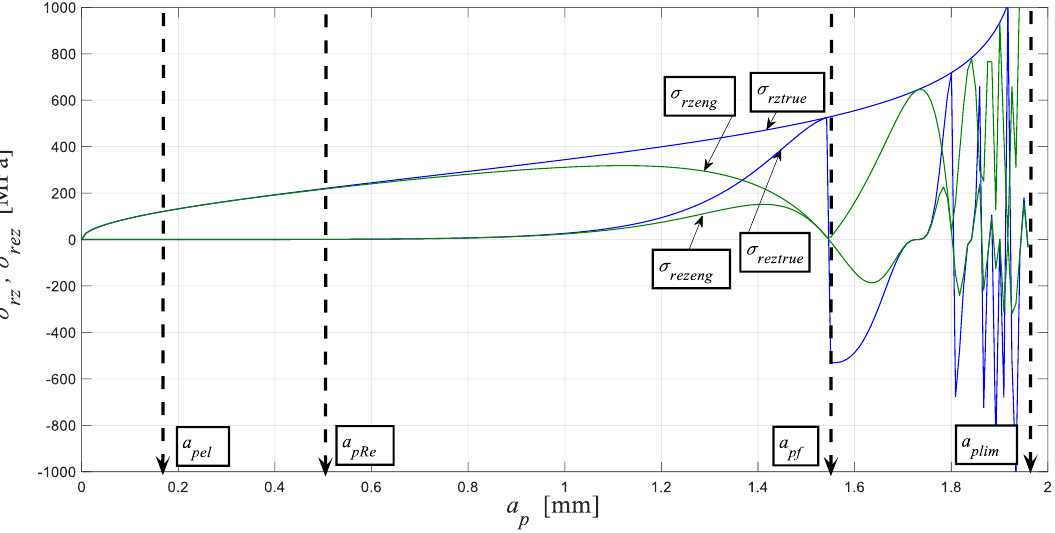
Figure 2. Relation σ rz – σ rez for EN S235JRG1 material.